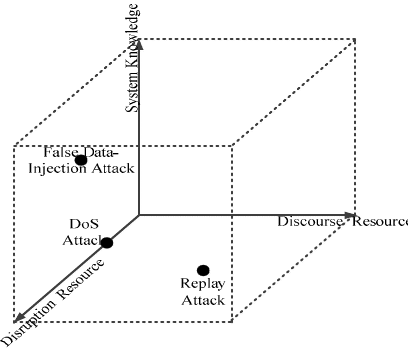
Figure 2. Three-dimensional attack space.